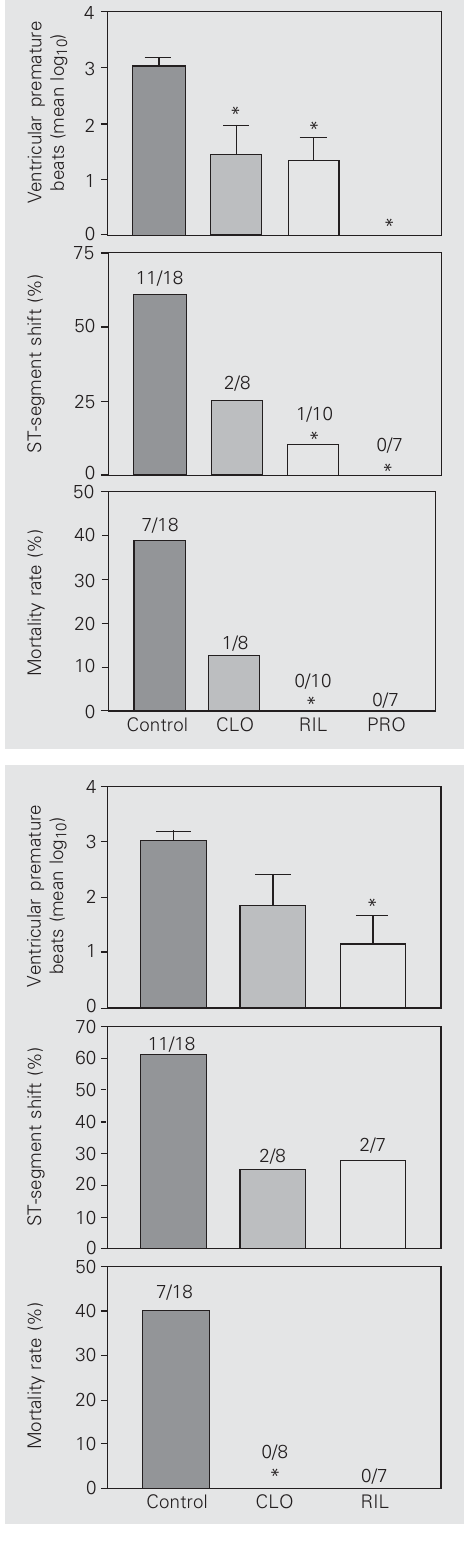
Figure 3. Effect of intravenous ( iv ) pretreatment with clonidine (CLO, 10 µg/kg), rilmenidine (RIL, 300 µg/kg) or propranolol (PRO, 500 µg/kg) on ventricular arrhythmia, ECG ischemic chan- ges and mortality rate observed after L-glutamate (10 µmol, icv ) in L-NAME (40 mg/kg, iv )-treated pentobarbital-anesthetized rab- bits. Ventricular premature beats are reported as log 10 values (see Methods). Data are reported as means and the vertical bars show the SEM. *P<0.05 vs con- trol group (Student-Newman- Keuls or Fisher exact test).